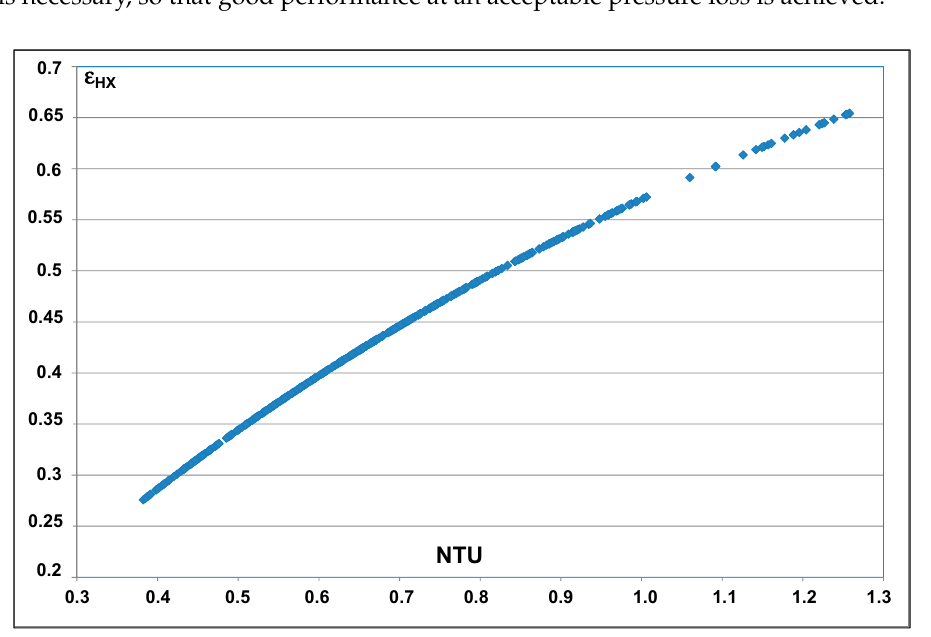
Figure 13. The outer ring cooling efficiency ε HX as a function of the Number of (heat) Transfer Units (NTU). The curve has been produced on the basis of the test results.